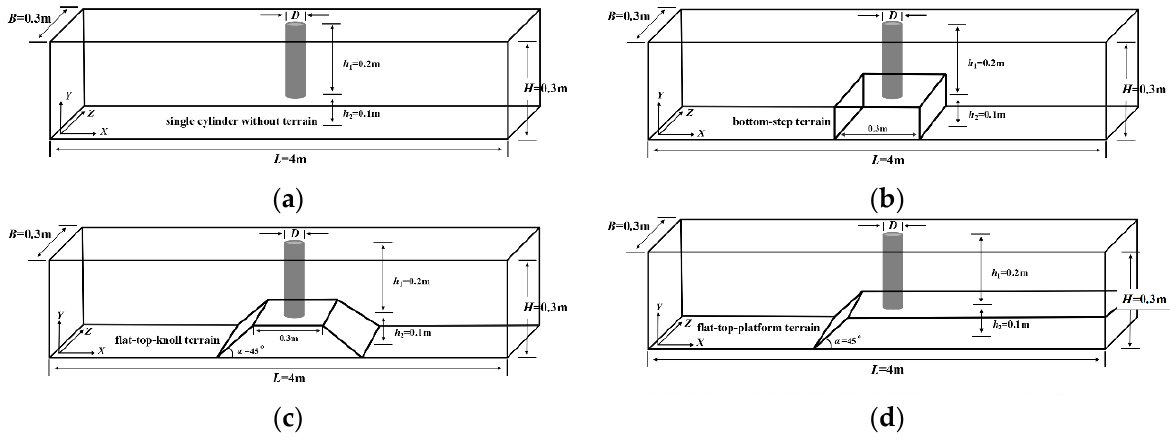
Figure 6. Sketch map of numerical tank for four cases: ( a ) N 1 ,( b ) N 2 ,( c ) N 3 , ( d ) N 4.